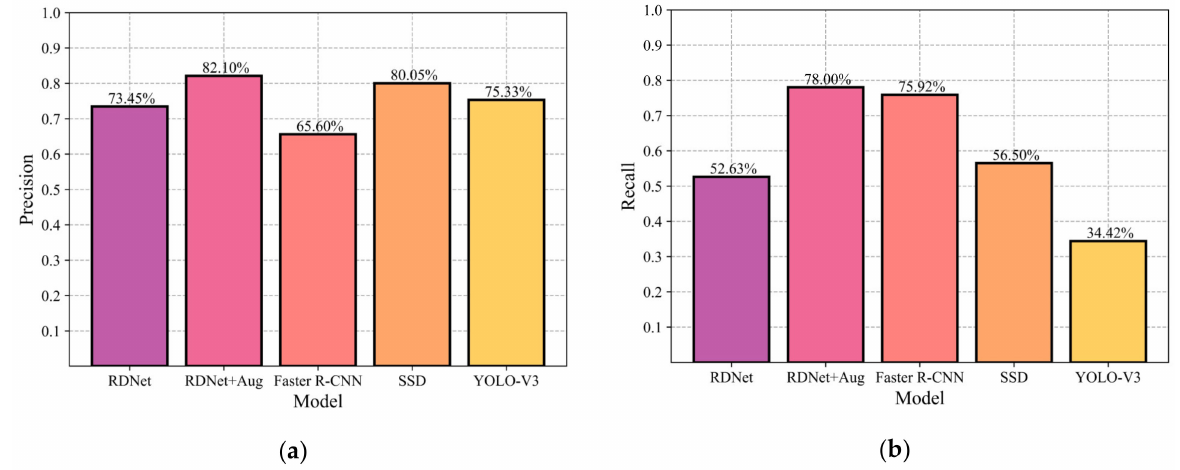
Figure 17. Comparison results of different models. ( a ) average precision on four multitype rock lithology of five models; ( b ) average recall on four multitype rock lithology of five models.